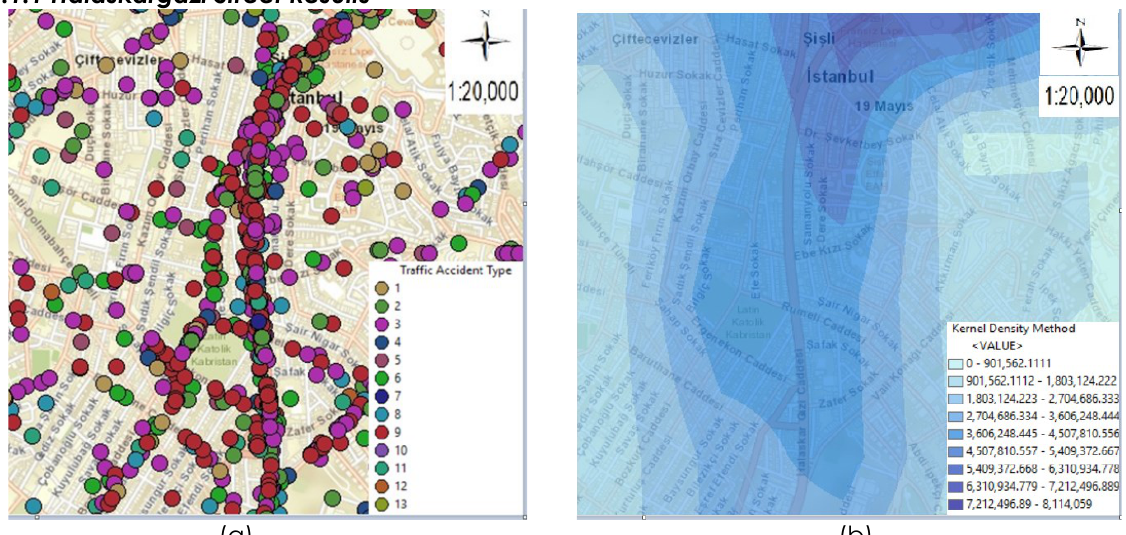
Figure 8. Maps of traffic accidents on Halaskargazi Street in Şişli district: (a) Thematic accident map by type of accident; (b) Kernel Density method map. In figure 8, maps of a total of 289 fatal